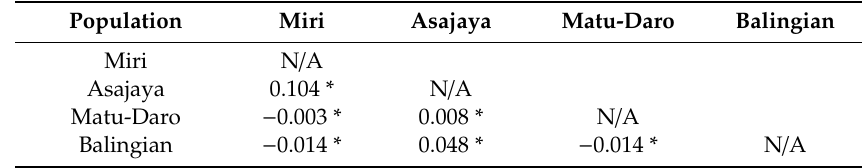
Table 3. Population subdivision (F ST ) values and probability test (Chi-square) for population di ff erentiation based on 1000 permutations of the sequence dataset. Genetic subdivision between populations was not detected as indicated by the negative F ST value and the high p -value ( p > 0.05). The low F ST value for Asajaya as with other population was also not statistically significant. G. boninense populations within Sarawak showed a homogenous genetic structure and high gene flow (migration index, Nm > 4).